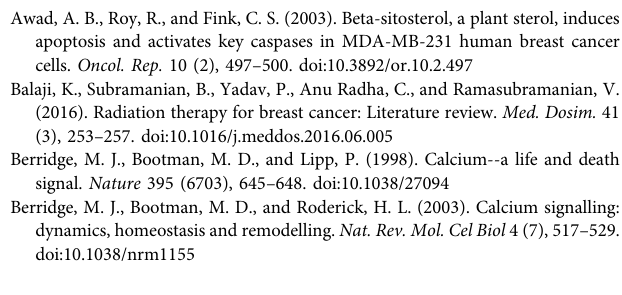
Supplementary Figure S1 | The process of ADME screening. Supplementary Figure S2 | The heatmap of DEGs of breast cancer. The red color represents the high expression of the gene and the green color represents the low expression of the gene. SupplementaryFigureS3| TheC-Tnetworkof RhizomaHeterosmilacis and Radix Sophorae Flavescentis . The targets were in yellow and the components were in the green. The common targets were placedat the centerofthe network.The targets at the left were the unique targets of Radix Sophorae Flavescentis , while those at the right were the unique targets of Rhizoma Heterosmilacis . The size of the targets and components were related to the degree. The higher degree represented the larger size. Supplementary Figure S4 | (A) The Venn diagram of the joint targets between BC and CKI and the targets of HCGSC. (B) The Venn diagram of the joint KEGG pathways between BC and CKI and the KEGG pathways of HCGSC. (C) The Venn diagramofjointGO-BPtermsbetween RadixSophoraeFlavescentis inHCGSCand Rhizoma Heterosmilacis in HCGSC. (D) The Venn diagram of the joint pathway between Radix Sophorae Flavescentis in HCGSC and Rhizoma Heterosmilacis in